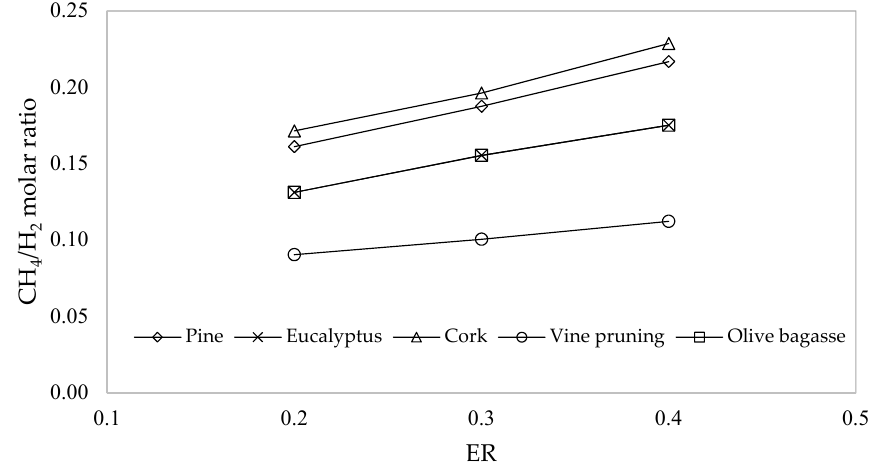
Figure 5. Produced gas CH 4 / H 2 molar ratio as a function of ER for various biomasses.